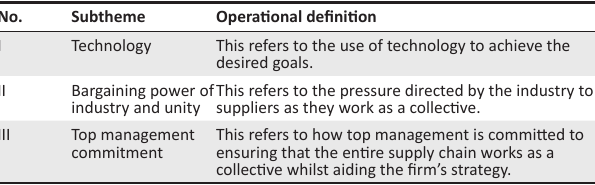
TABLE 2: Operational definitions for supply chain